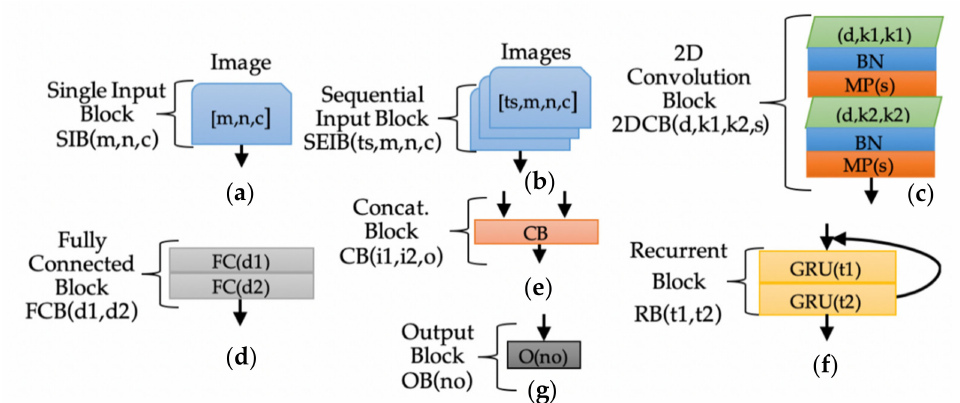
Figure 8. High abstraction block for design of e2e architectures: ( a ) single input block (SIB); ( b ) se- quential input block (SEIB); ( c ) 2D convolution block (2DCB); ( d ) fully connected block